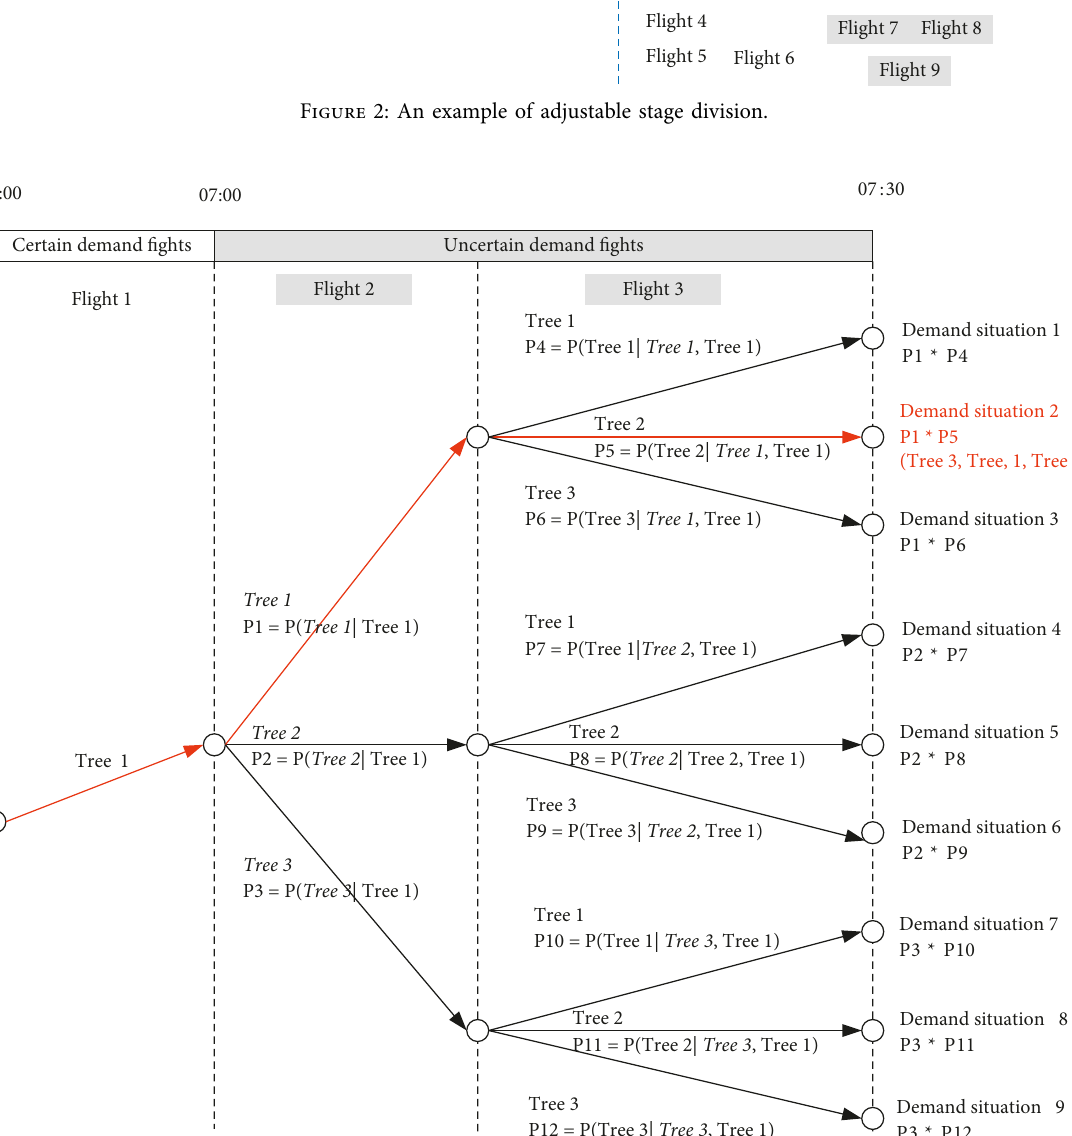
Figure 3: Structure of the scenario